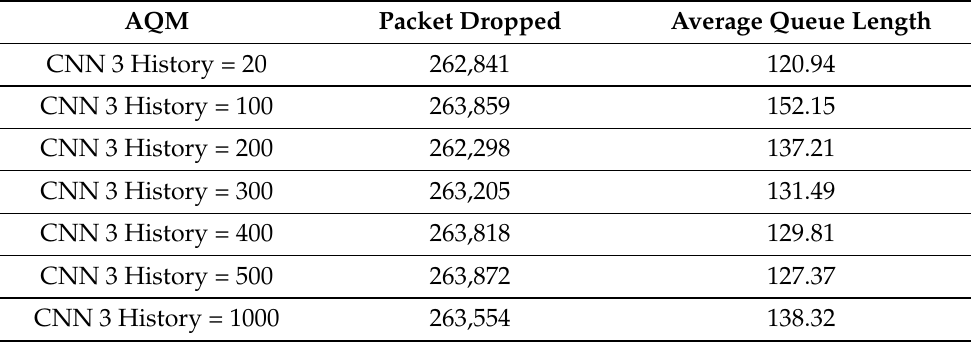
Table 15. Detailed results of queue occupancy results obtained for CNN model trained using data regarding three PI α controllers and H =